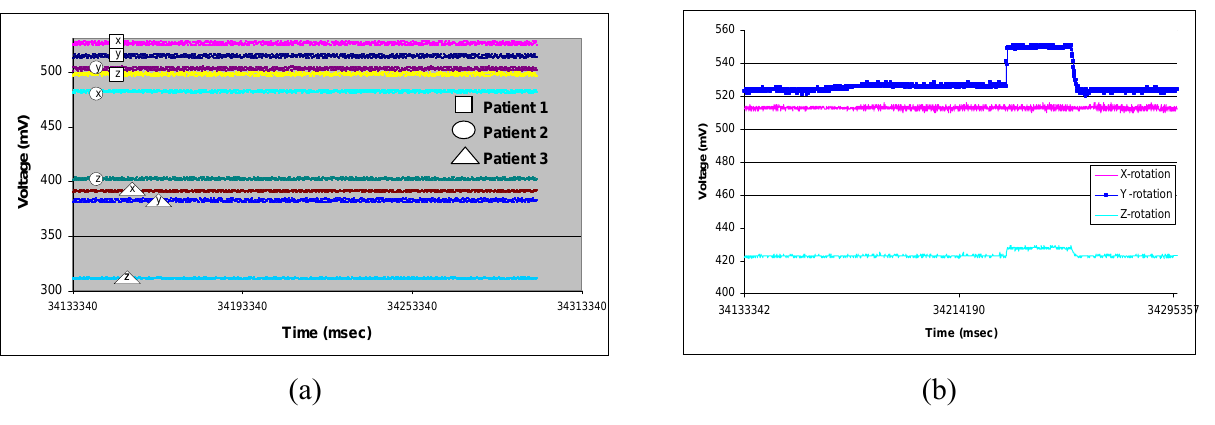
Figure 7. APOMS reading for all three axes: (a) typical voltage readouts for three different patients undergoing radiation for about three minutes; (b) patient tilting her